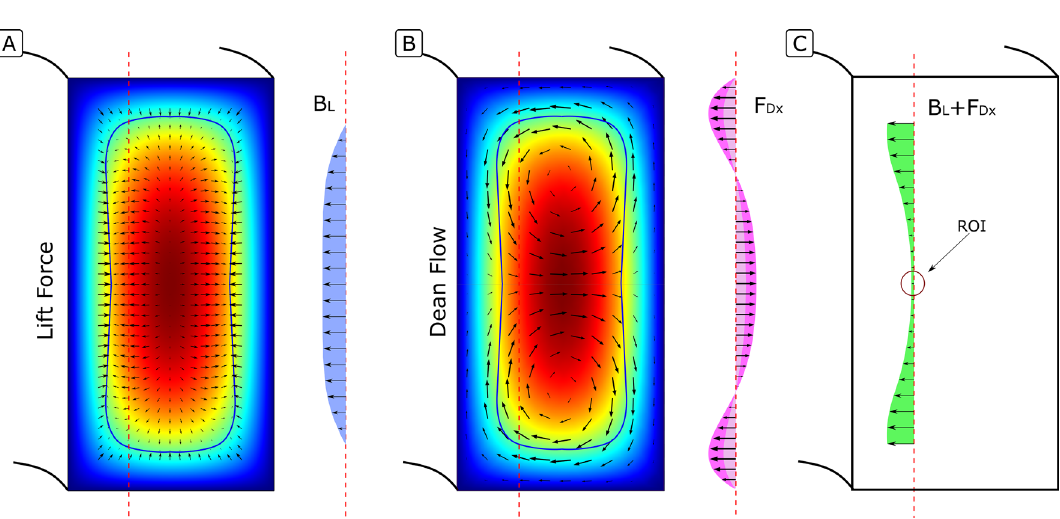
Figure 4. ( A ) Generic force field of F L and isolation of the horizontal component at W / 3 . ( B ) Generic force field of F D and isolation of the horizontal component at W / 3 . The different tonality of the isolated component indicates how it grows as the secondary flow gains strength. ( C ) Combination of both forces at W / 3 inner wall, the last position where particles focused experimentally prior to defocusing with further increase of Q , see Fig. 3. In the model used in this paper, further analysis of the phenomenon was done at this particu- lar location. Figure 4A sketches the distribution of F L proposed by Liu 21 , isolating its horizontal value at W / 3 from the inner wall ( B L ). Figure 4B sketches the distribution of F D in HARC channels obtained by COMSOL simulations, isolating its horizontal value at W / 3 from the inner wall ( F Dx ). Last, Fig. 4C shows the result of the